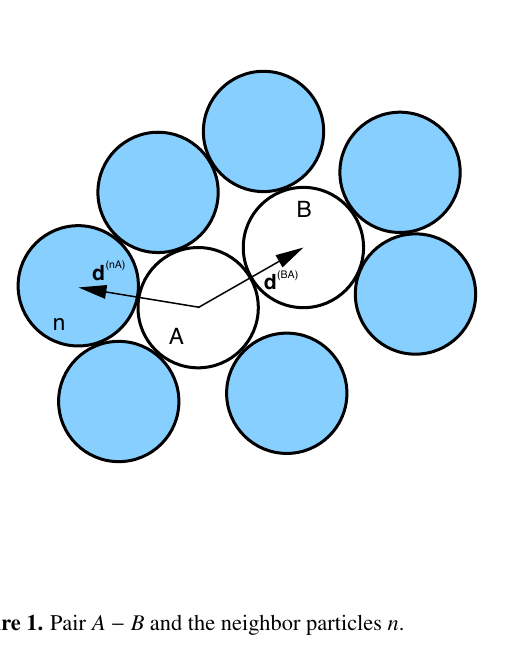
Figure 1. Pair A − B and the neighbor particles n